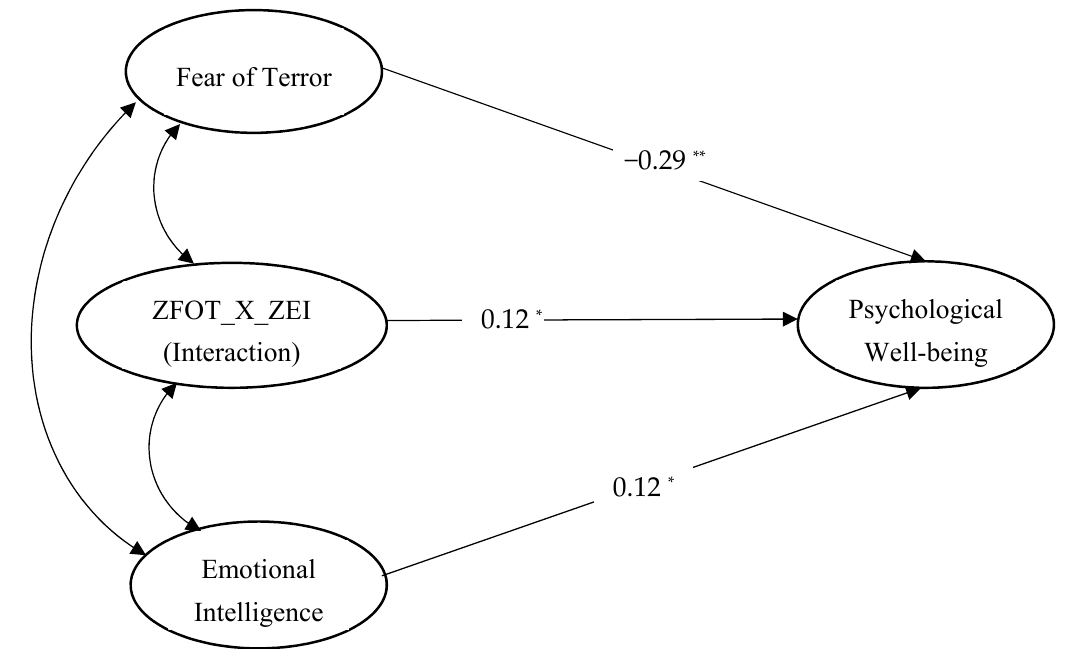
Figure 1. Standardized path coefficients of the structural equation model. Note: ZFOT_X_ZEI = Interaction of the fear of terror and emotional intelligence calculated by multiplying the standardized values of both variables. * p < 0.05. ** p < 0.01.